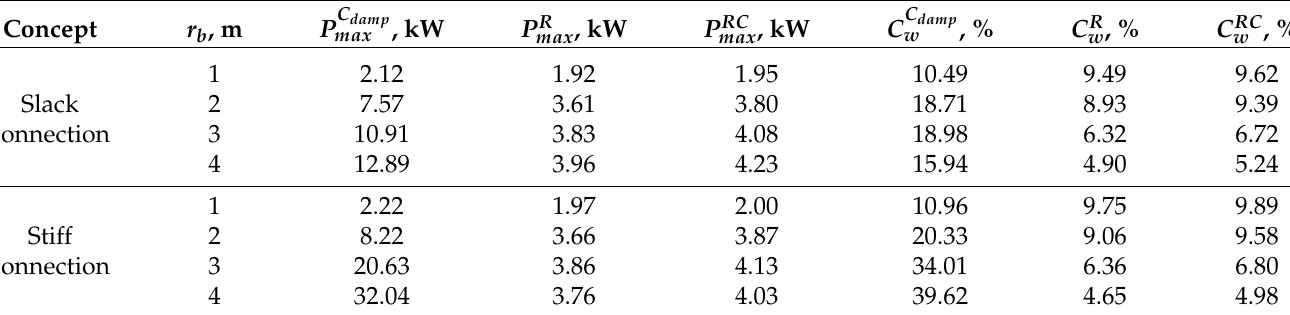
Table 5. Capture width ratio and average values of power for each case.